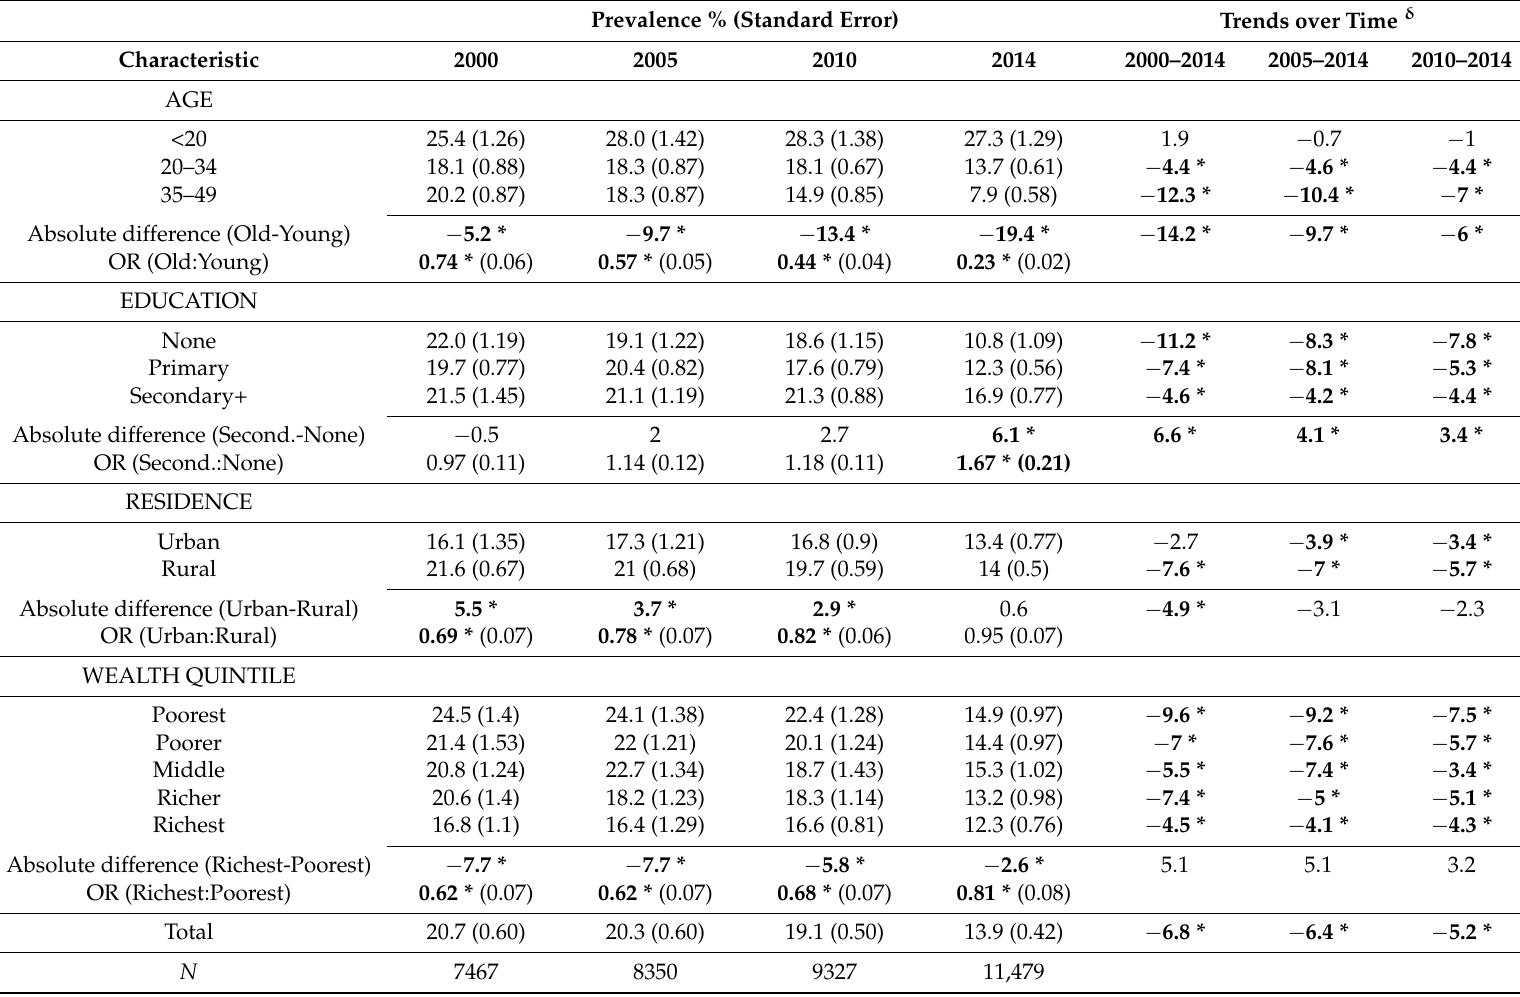
Table 2. Prevalence of underweight in women in the four surveys according to their social characteristics. Prevalence % (Standard